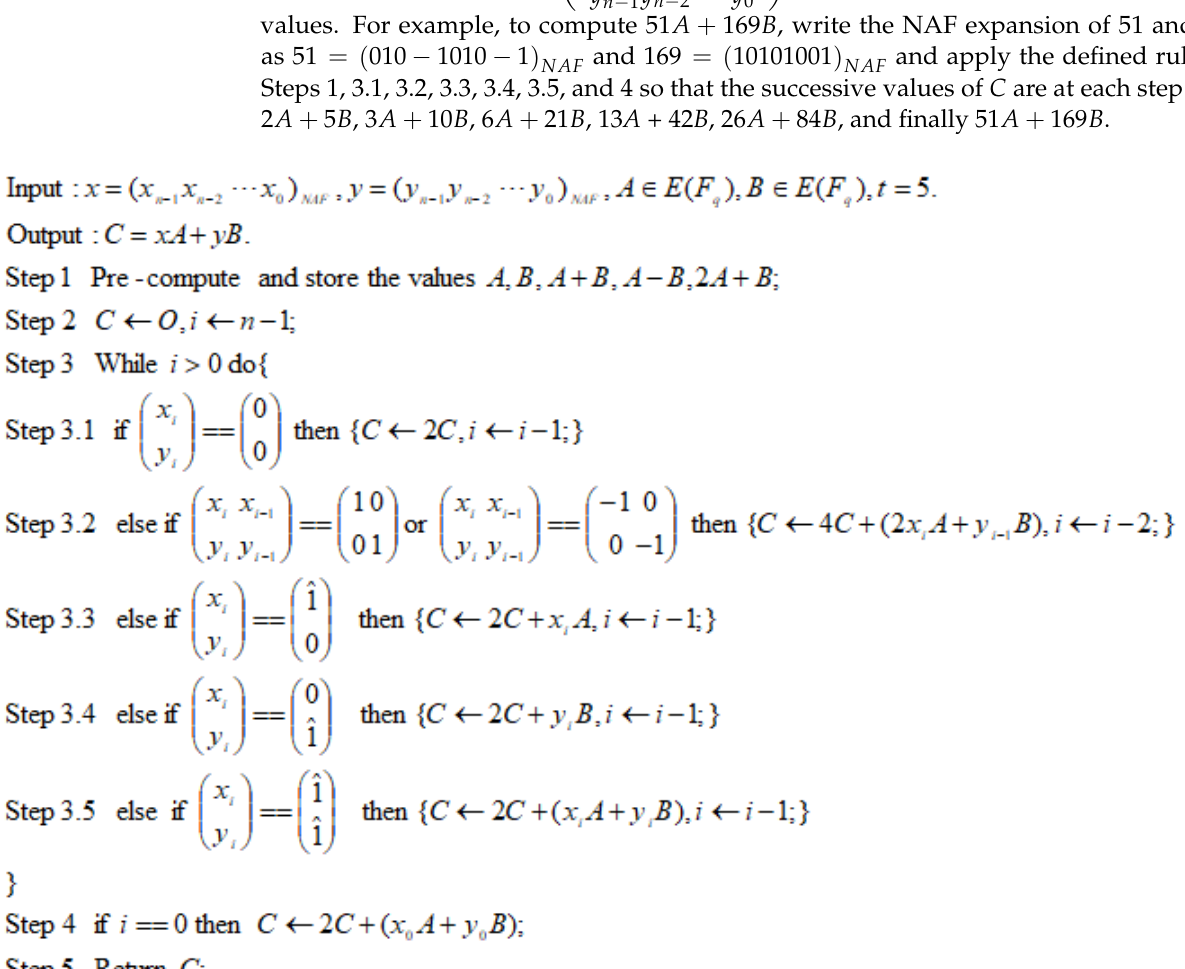
Algorithm The 5-register algorithm using the non-adjacent form (NAF) representation in Figure 3 correspondingly requires the values A , B , A + B , A − B , and 2 A + B . Additionally, Step 3 scans and collects the pairs in the NAF sequence pair and then computes their corresponding values. For example, to compute 51 A + 169 B , write the NAF expansion of 51 and 169